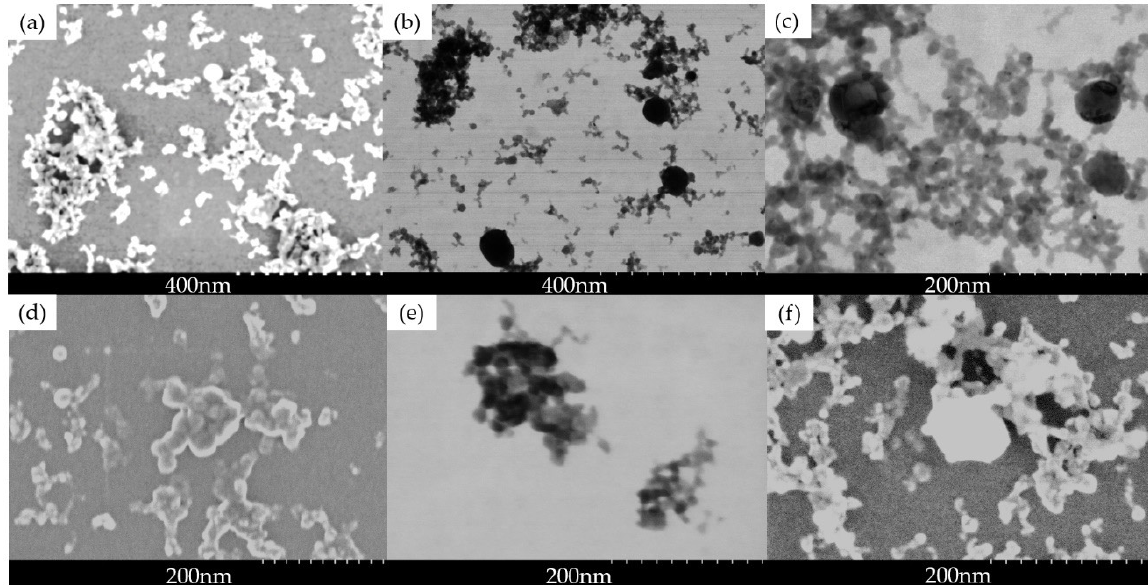
Figure 8. SEM images: ( a ) SEM image of sample 27C at 400 nm magnification and 30 kV acceleration voltage. ( b ) SEM image of sample 9C at 400 nm magnification and 20 kV acceleration voltage. ( c ) SEM image of sample 9C at 200 nm magnification and 30 kV acceleration voltage. ( d ) SEM image of sample 27C at 200 nm magnification and 30 kV acceleration voltage. ( e ) SEM image of sample 21C at 200 nm magnification and 20 kV acceleration voltage. ( f ) SEM image of sample 9C at 200 nm magnification and 9 kV acceleration voltage.